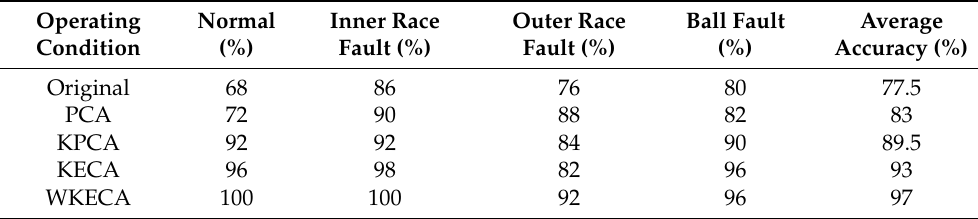
Table 1. The classification accuracies of different methods to the bearing sets with support vector machine (SVM) classifier.